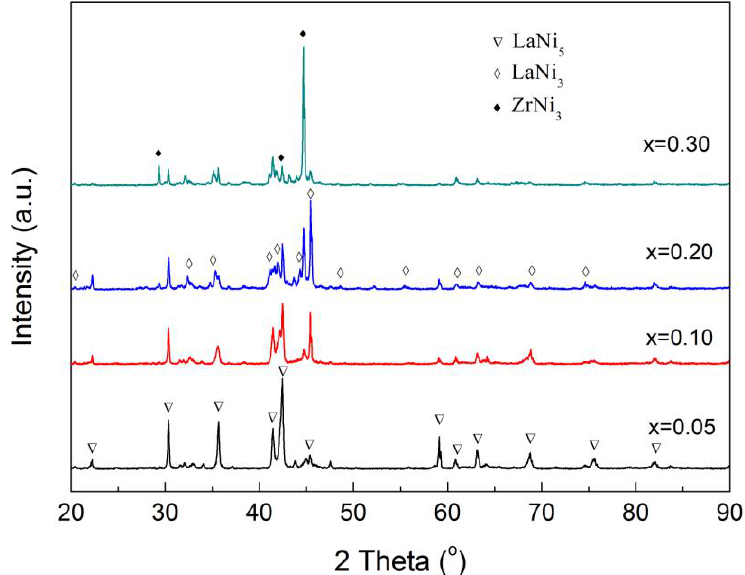
Figure 1. XRD patterns of La